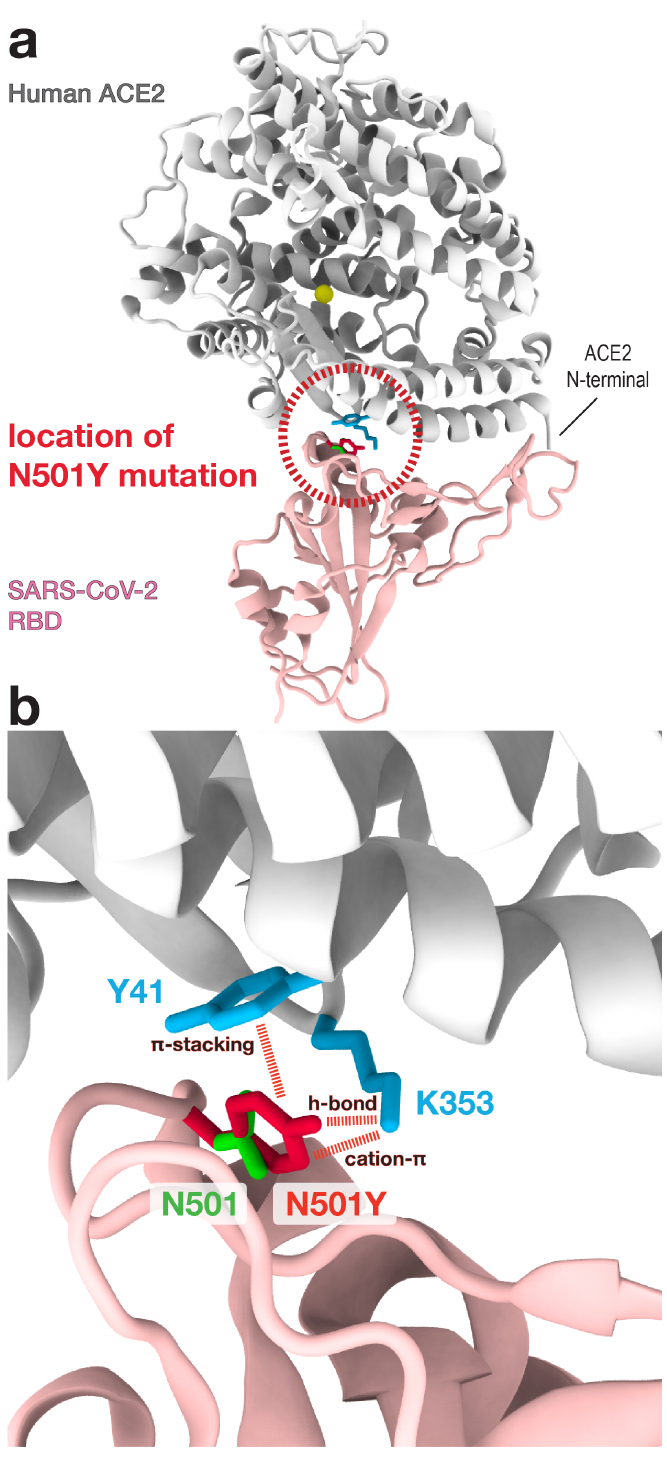
Figure 3. N501Y mutation introduces additional stabilizing interactions between RBD and ACE2. ( a ) Dashed circle indicates the location of the N501Y mutation site in RBD, which is at the binding interface with ACE2. ( b ) Zoomed-in view of N501Y location (i.e., dashed circle region of panel ( a )). The wild type residue N501 of RBD is shown in green, and the mutation N501Y in red. The simulations show that N501 forms persistent short-range contacts with Y41 and K353 (cyan) of ACE2 (cf. Figure2a). Based on this, we assess how the N501Y mutation may alter the interactions with these ACE2 residues. As shown by dashed lines and their labels, N501Y would introduce additional stabilizing interactions with Y41 and K353 of ACE2, which will increase the binding affinity between RBD and